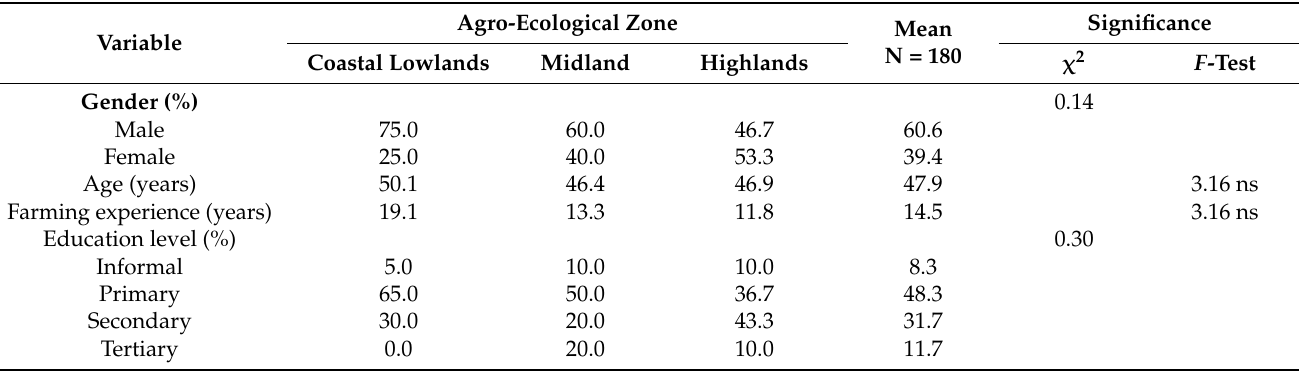
Table 1. Socio-demographic characteristics of smallholder farmers interviewed during the survey for fall armyworm infestation and damage in three agro-ecological zones of Kenya in